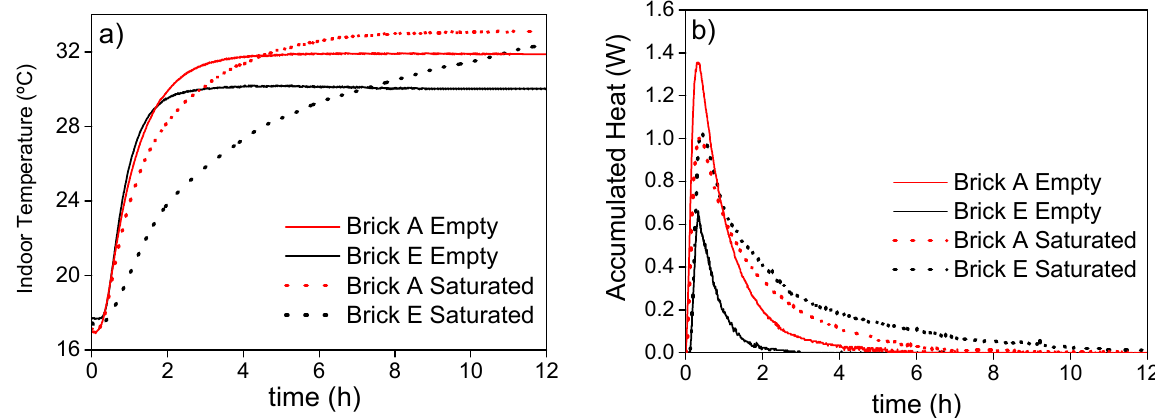
Figure 11. Indoor temperature ( T up) ( a ) and accumulated heat ( b ) of brick type E for the empty and saturated conditions when it is subjected to a thermal change from 15 to 42 °C.